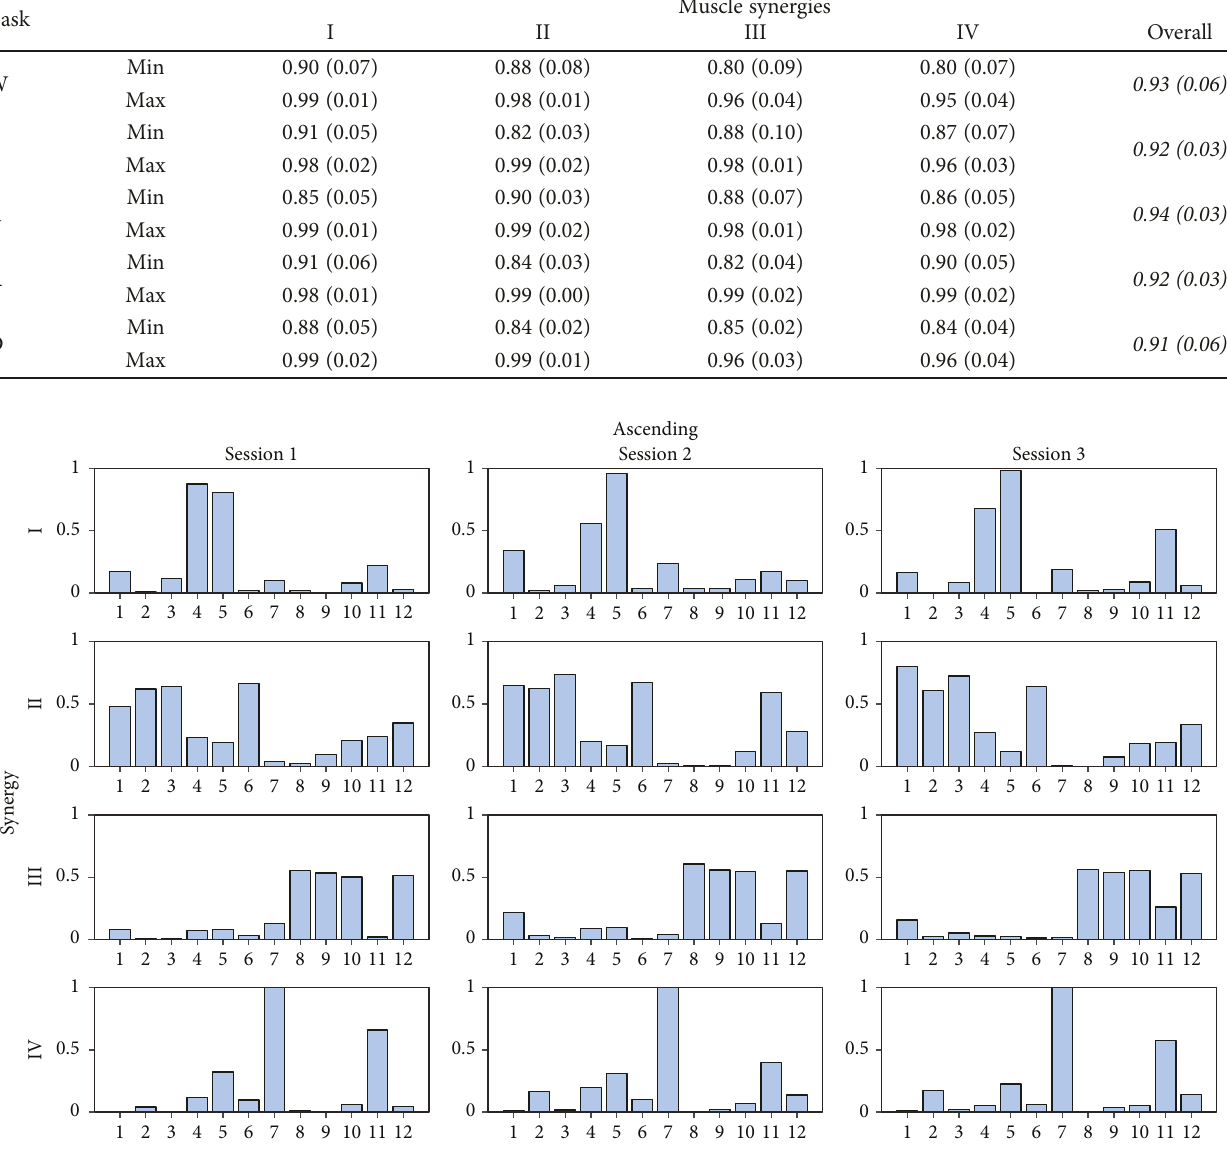
Figure 4: A paradigmatic example of the mean value of muscle synergy vectors in the 4-synergy model related to the ascending task for one subject for each session. The mean has been obtained averaging the repetitions of the same session. For visualization purposes, muscle synergy vectors are normalized to unity. Muscle numbers: 1: TFL; 2: REF; 3: VLAT; 4: VMED; 5: PERO; 6: TA; 7: SOL; 8: GLU; 9: SEMT; 10: BIF; 11: LGAS; 12: